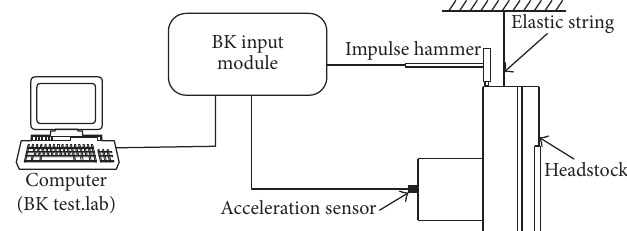
Figure 12: Measuring apparatus for the frequency response of the